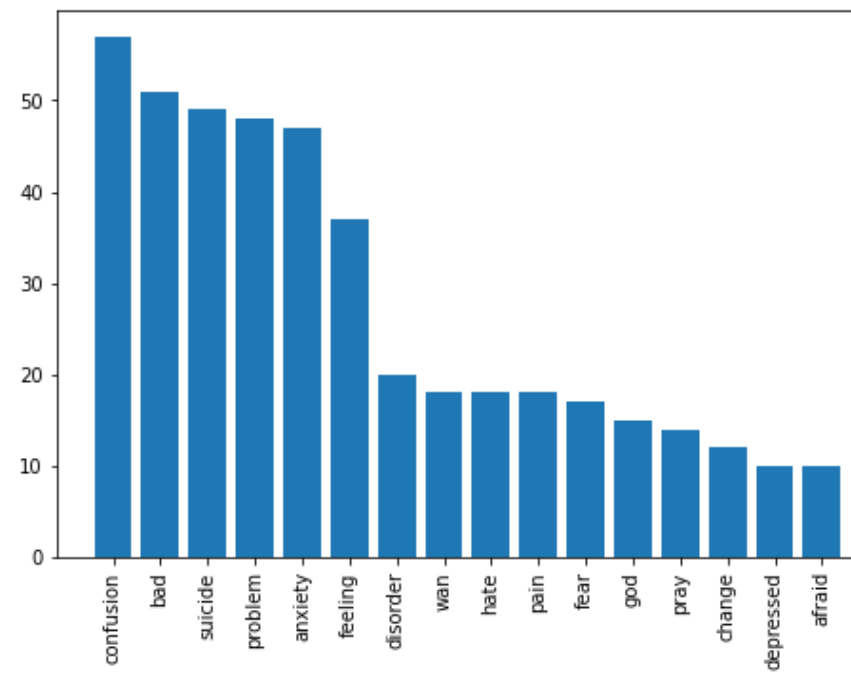
Figure 6. The most utilized words expressing fear.